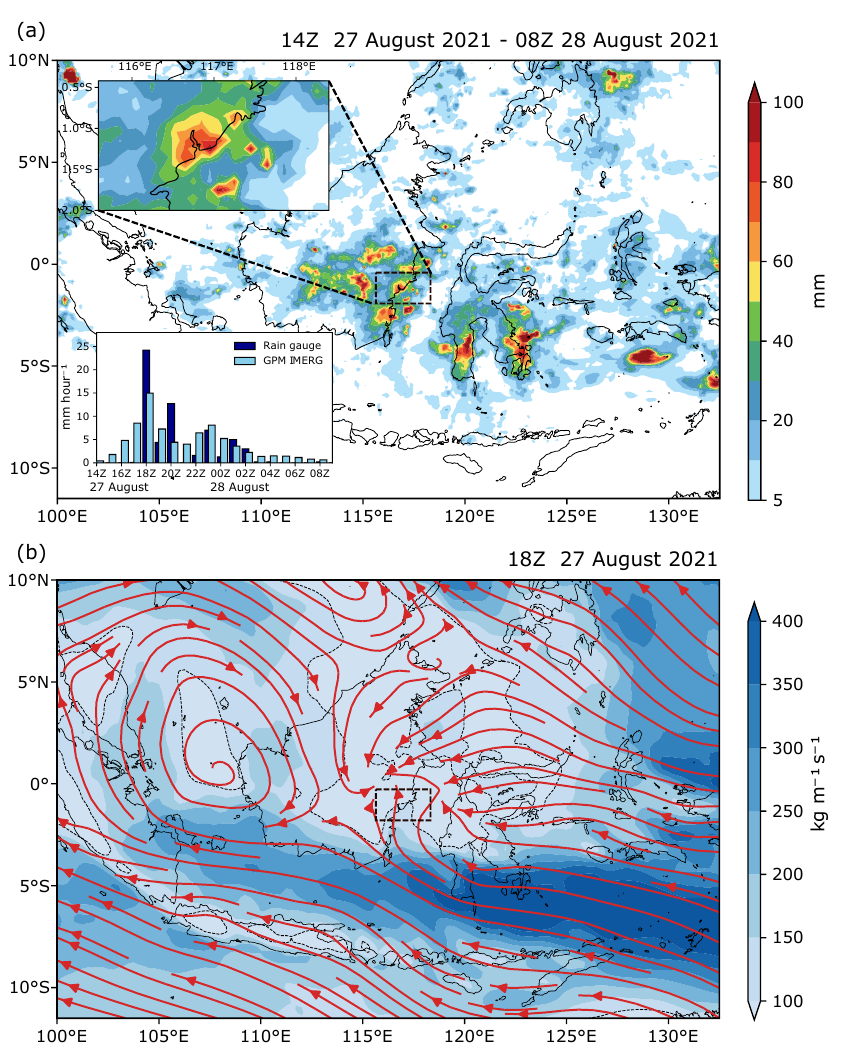
Figure 3. ( a ) Spatial distribution of precipitation accumulation between 14Z 27 August 2021 to 08Z 28 August 2021 (color shading) in Indonesia. The inset map denotes the precipitation accumulation zoomed-in over the Nusantara city region. The time series histogram shows the hourly precipitation observed by rain gauge of Sepinggan (dark blue) and area-averaged hourly precipitation of Nusan- tara and the surrounding area based on GPM IMERG (sky blue). ( b ) The shade color represents 1000–300 hPa vertically integrated moisture condition and red streamline shows vertically integrated moisture flux at 18Z 27 August